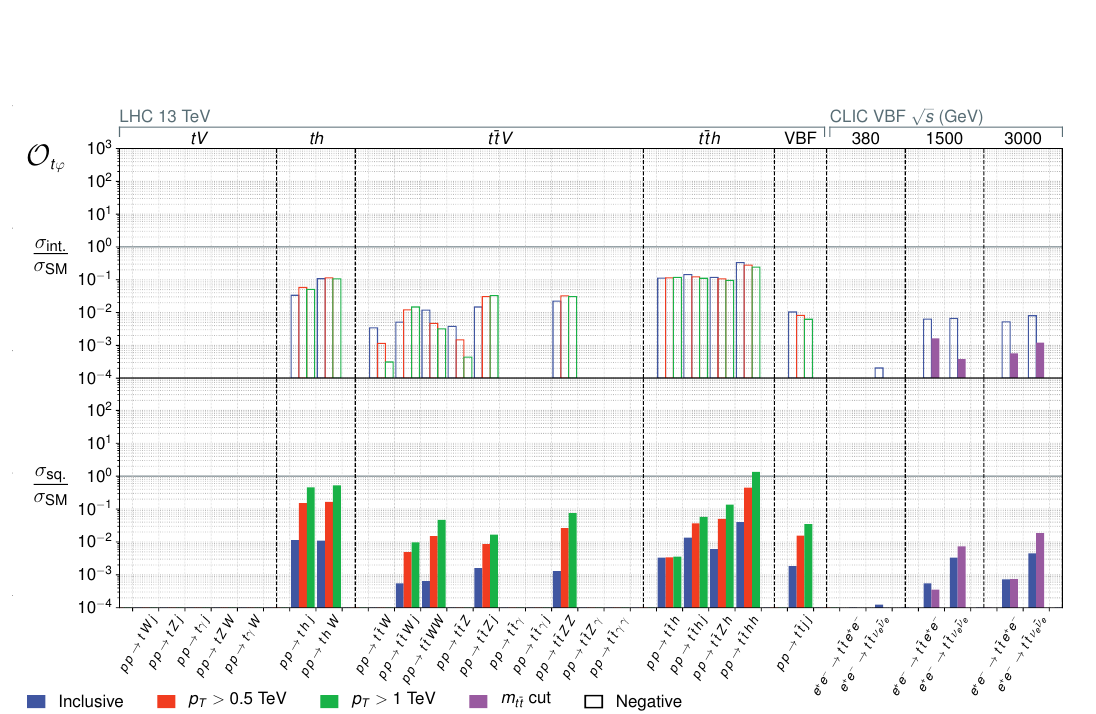
Figure 43. Same as (cid:12)gure 40 for